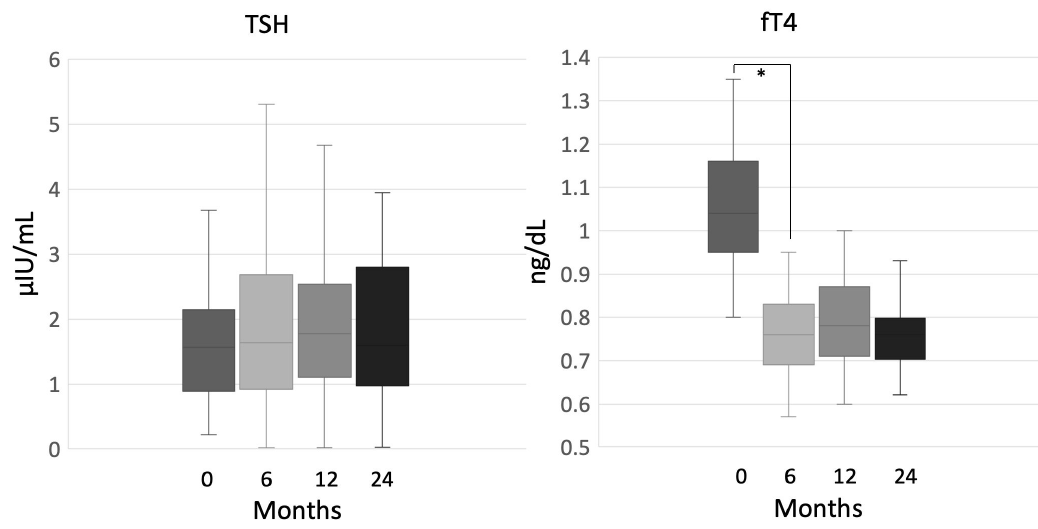
Figure 3. Thyroid-stimulating hormone (TSH) and free thyroxine (fT4) during mitotane therapy; * indicates statistical significance, Note: patients who were put on levothyroxine replacement were excluded from the